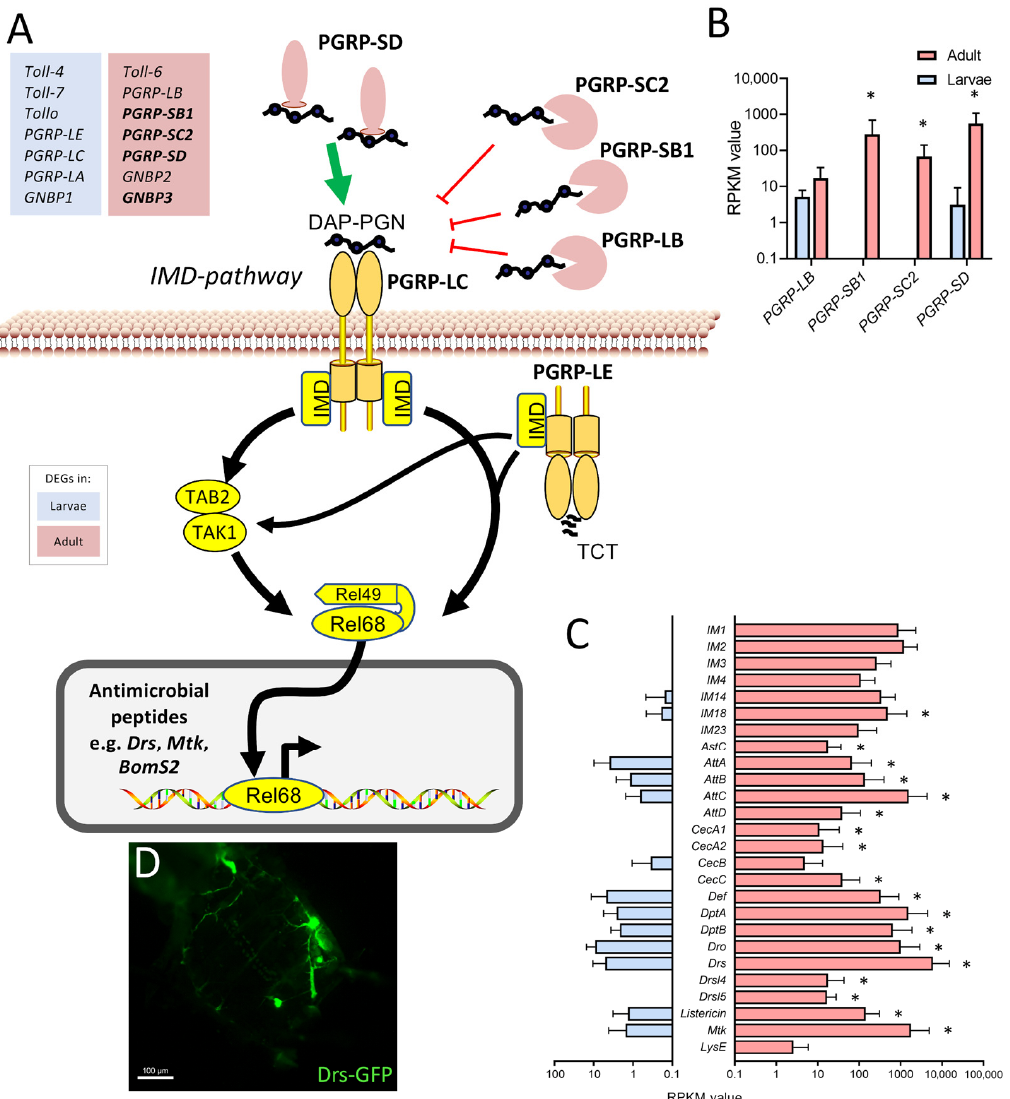
Figure 6. Components of the immune system expressed at higher levels in the adult trachea. ( A ) Schematic overview of the extra- and intracellular components of the IMD pathway. ( B ) RPKM ex- pression values of different PGRPs compared between larval (blue) and adult trachea (red). ( C ) RPKM expression values of different antimicrobial molecules compared between larval and adult trachea. Asterisks indicate a differential gene expression based on the RNA-Seq analysis. Bars show mean with SD, n = 4. ( D ) Drs -GFP expression in the trachea of the adult abdomen.